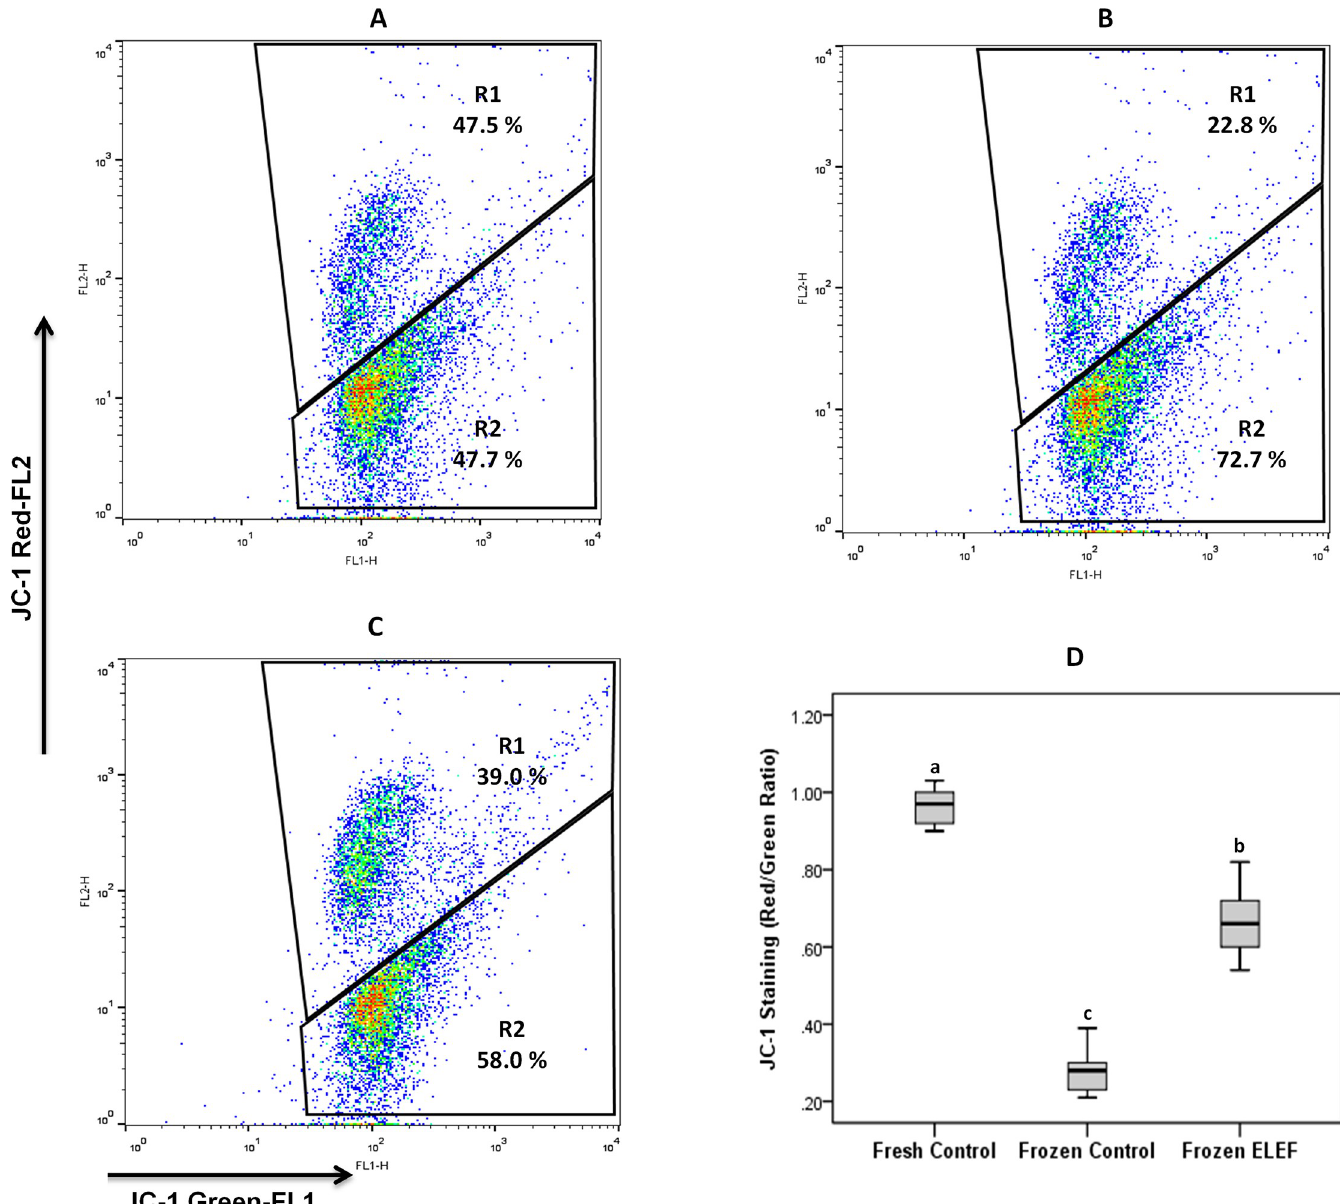
Fig 6. Representative flow cytometry for (A) fresh control stained with JC-1; (B) frozen control sperm stained with JC-1; (C) frozen ELEF. Box-and-whisker plots for sperm MMP from the three experimental groups (D). The percentage values represent the proportion of sperm with high MMP (top right quadrant) and low MMP (bottom right quadrant). The assigned letters of a, b and c indicate significant differences (p < 0.05) among the groups. Values are expressed as mean ± SD.